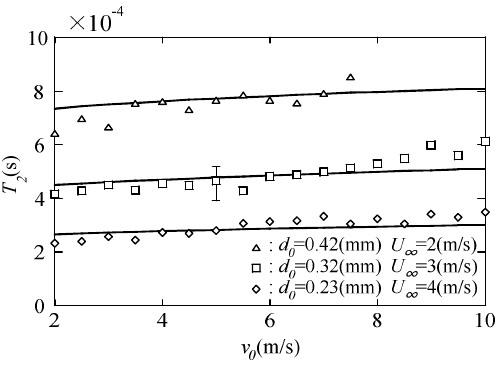
Fig. 11 Inflowing time during the second